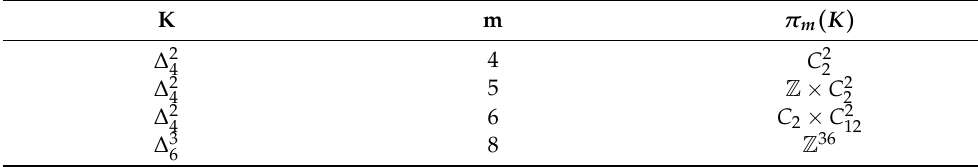
Table 1. Homotopy groups of the complex of not i -connected graphs on n